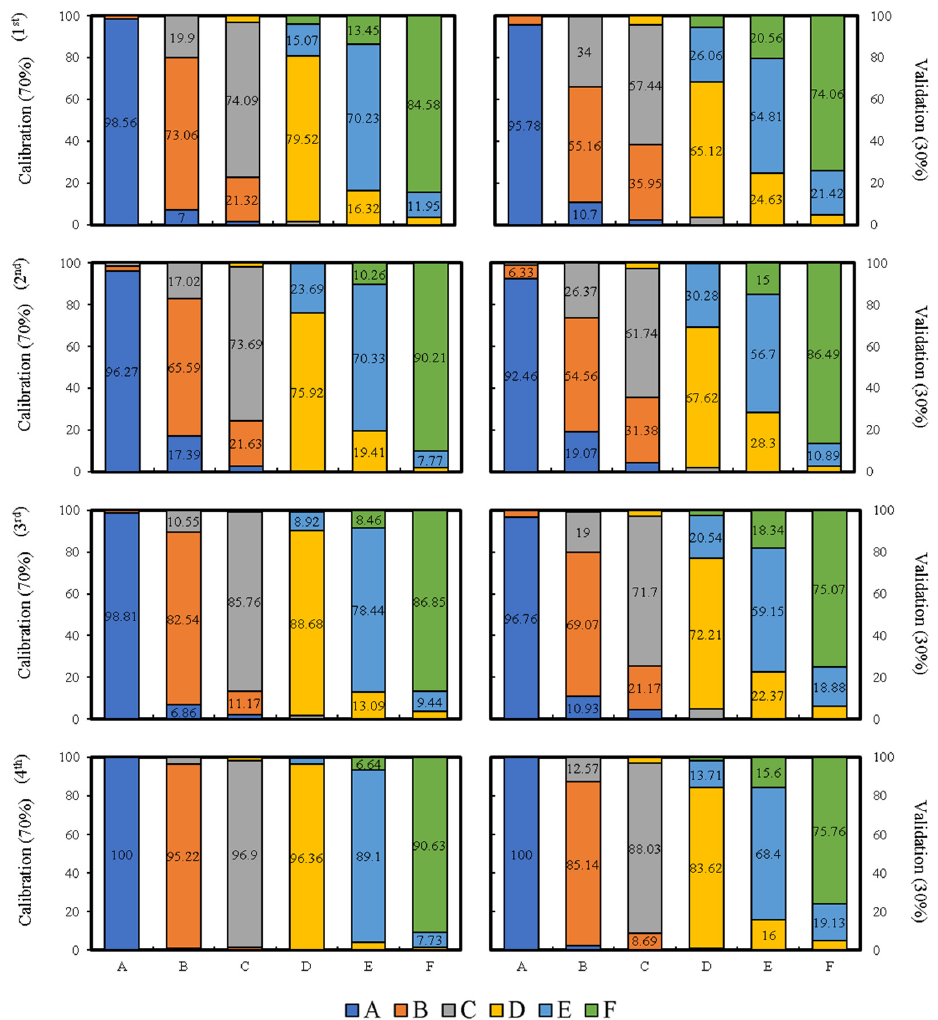
Figure 4. Accuracy of the discriminant models for calibration and validation of the four soil assessments (1st = first assessment; 2nd = second assessment; 3rd = third assessment; 4th = fourth assessment) of six different layers (A = 0.00–0.05 m, B = 0.05–0.10 m, C = 0.10–0.20 m, D = 0.20–0.30 m, E = 0.30–0.40 m, F = 0.40–0.60 m).